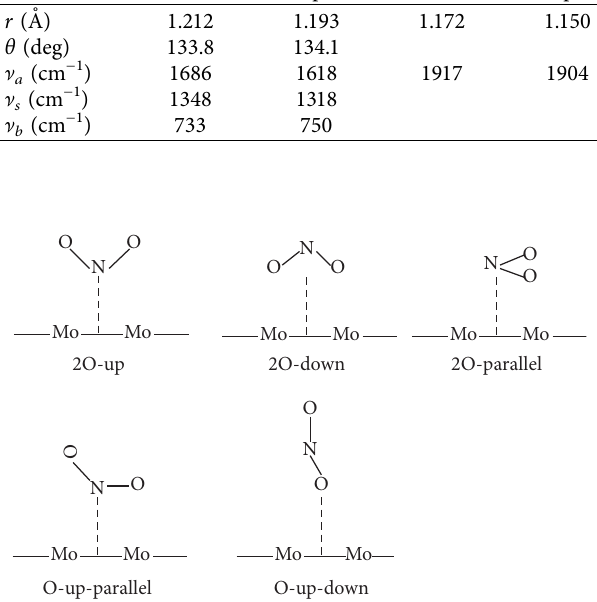
Figure 2: Schematic diagram of possible adsorption states of adsorbed NO 2